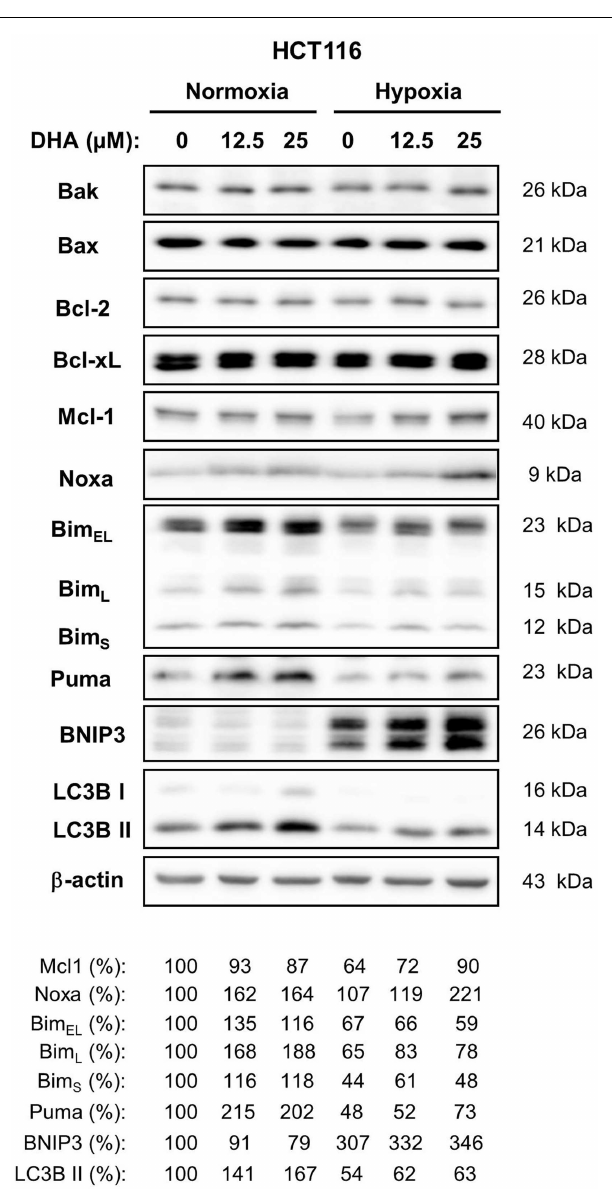
FIGURE 6 | BH3-only proteins Bim, Puma, Noxa, and BNIP3 are differentially regulated in response DHA in normoxia and hypoxia . HCT116 cells were treated with 0, 12.5, or 25 µ M DHA under normoxic or under hypoxic conditions as indicated.Twenty-four hours later, whole cell lysates were made. Levels of anti-apoptotic and pro-apoptotic proteins of the Bcl-2 family were analyzed by western blot. Induction of autophagy was accessed by western blot using an antibody against LC3B and a subsequent analysis of processed LC3B form (LC3B II, 14kDa). Levels of anti-apoptotic Bcl-2 and Bcl-xL and pro-apoptotic Bax and Bak did not change in response to treatment with DHA under normoxic and hypoxic conditions. Levels of BH3-only protein Noxa were increased in response to DHA in normoxia as well as in hypoxia. Levels of Bim and Puma were only increased by DHA in normoxia, whereas levels of BNIP3 were elevated by DHA only in hypoxia. Induction of autophagy in response to DHA was observed only under normoxic conditions. Protein levels were analyzed by densitometry and normalized to β -actin levels. Relative protein levels are shown below the respective blots. Data show representative blots from at least two independent